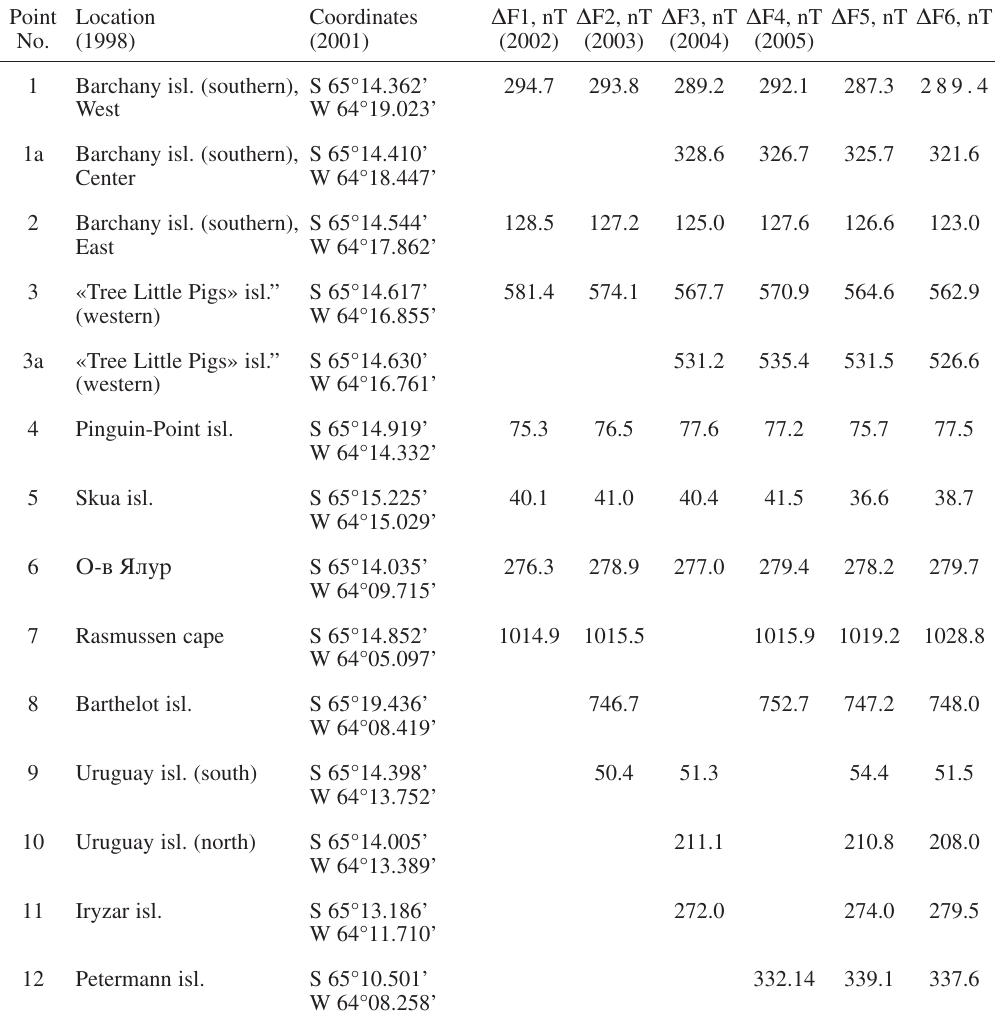
Table I. The results of measurements of differential geomagnetic field DF in the tectonomagnetic polygon in the location of UAS Point Location